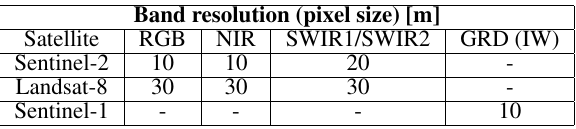
Table 1. Band resolution of Sentinel-2, Landsat-8, and Sentinel-1: RGB, Near-infrared (NIR), Short-wave infrared (SWIR), and Ground Range Detected (GRD) Interferometric Wide